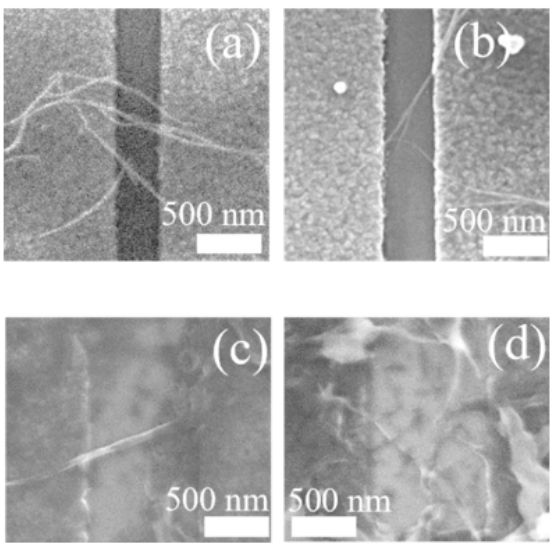
Figure 2. FE-SEM images of CNT-networks deposited by inkjet printing at low density from a 99.9% semiconductor-CNT solution after 4 h of ultrasonication on various source-drain gaps. ( a , b ) FE-SEM images of two different paths in a CNT-FET with a rectangular gap (designed gap, W gap = 500 nm) between Al source and drain electrodes. ( c , d ) FE-SEM images of two different paths in a CNT-FET with a rectangular gap (designed gap, W gap = 1000 nm) between Al source and drain electrodes.